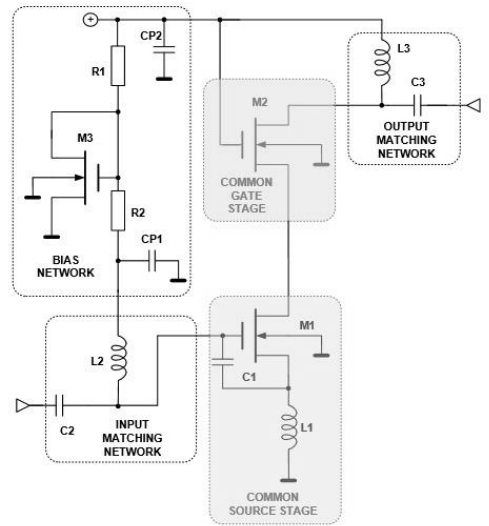
Figure 7. Cascode low noise amplifier (LNA) block diagram.